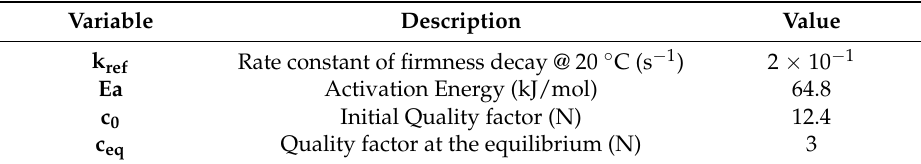
Table 2. Kinetic Parameters for firmness tomatoes SL modulation [6,19,20].